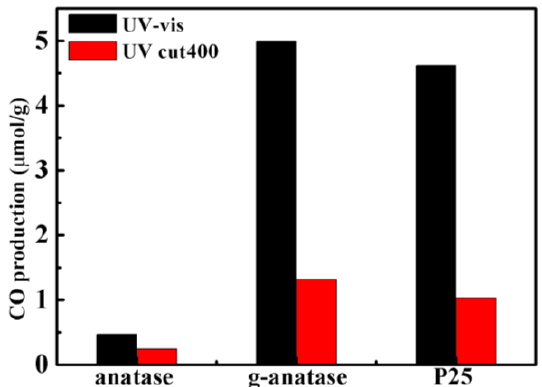
Figure 1. The histogram of CO maximum output with 6 h using anatase, colored anatase and P25 as the catalysts. g-anatase, gray anatase.